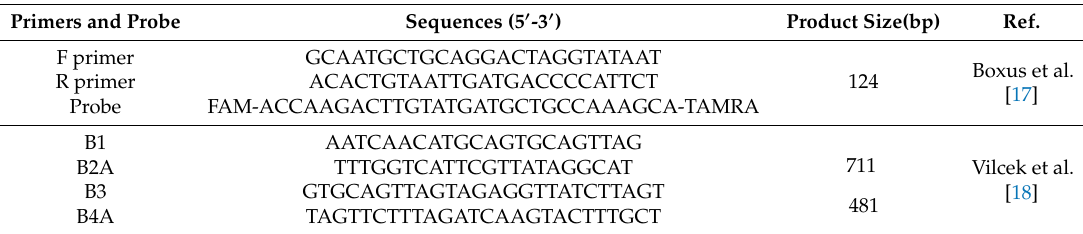
Table 1. Information on the primers and probes used in the